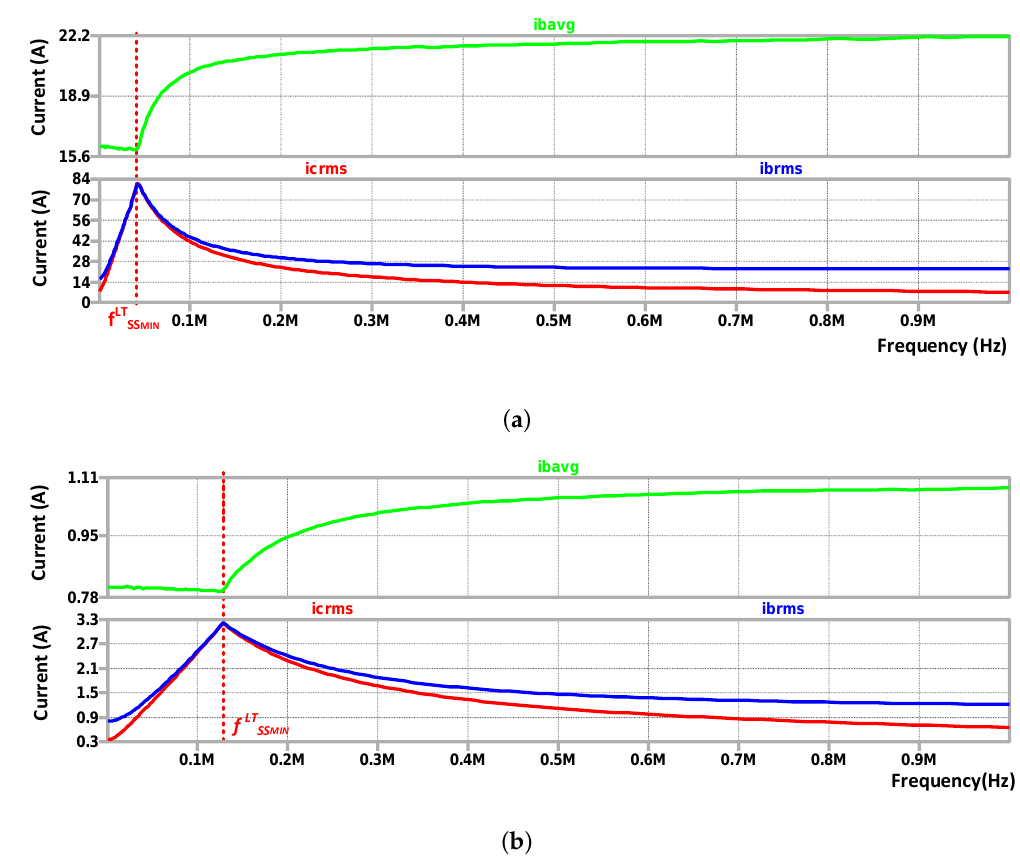
Figure 5. Battery average current ibavg , capacitor C 0 rms current icrms , and battery rms current ibrms as a function of the WPT excitation frequency f SS , for Test 1 ( a ) and Test 2 ( b